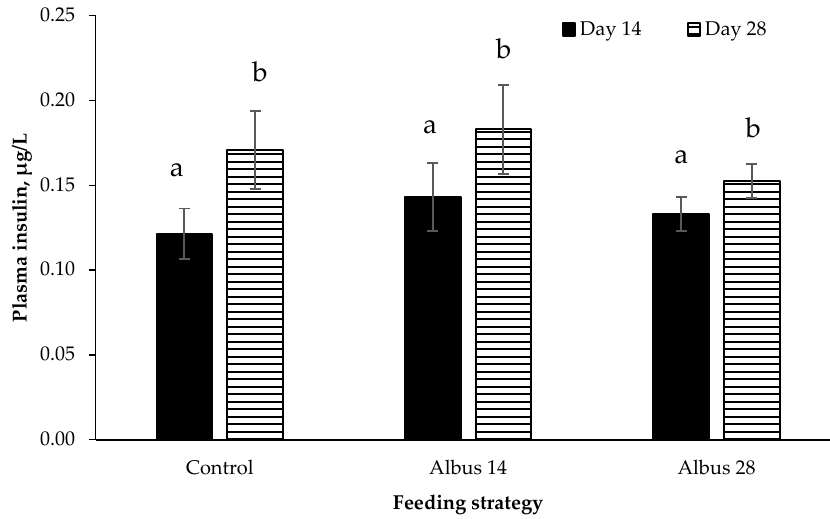
Figure 2. Plasma insulin concentration on day 14 and day 28 after the after the implementation of the experimental diets (mean ± SE; n = 24). Plasma insulin increased with time ( p = 0.037). Data for entire males and IC males have been pooled as there was no effect of sex or any interactions ( p > 0.05). a,b Different superscripts within diets are significantly different.